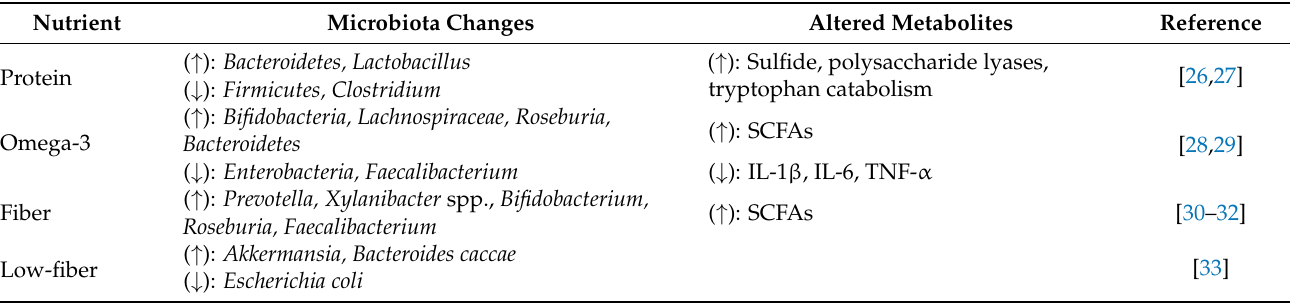
Table 1. Changes in gut microbiota and metabolites in different types of